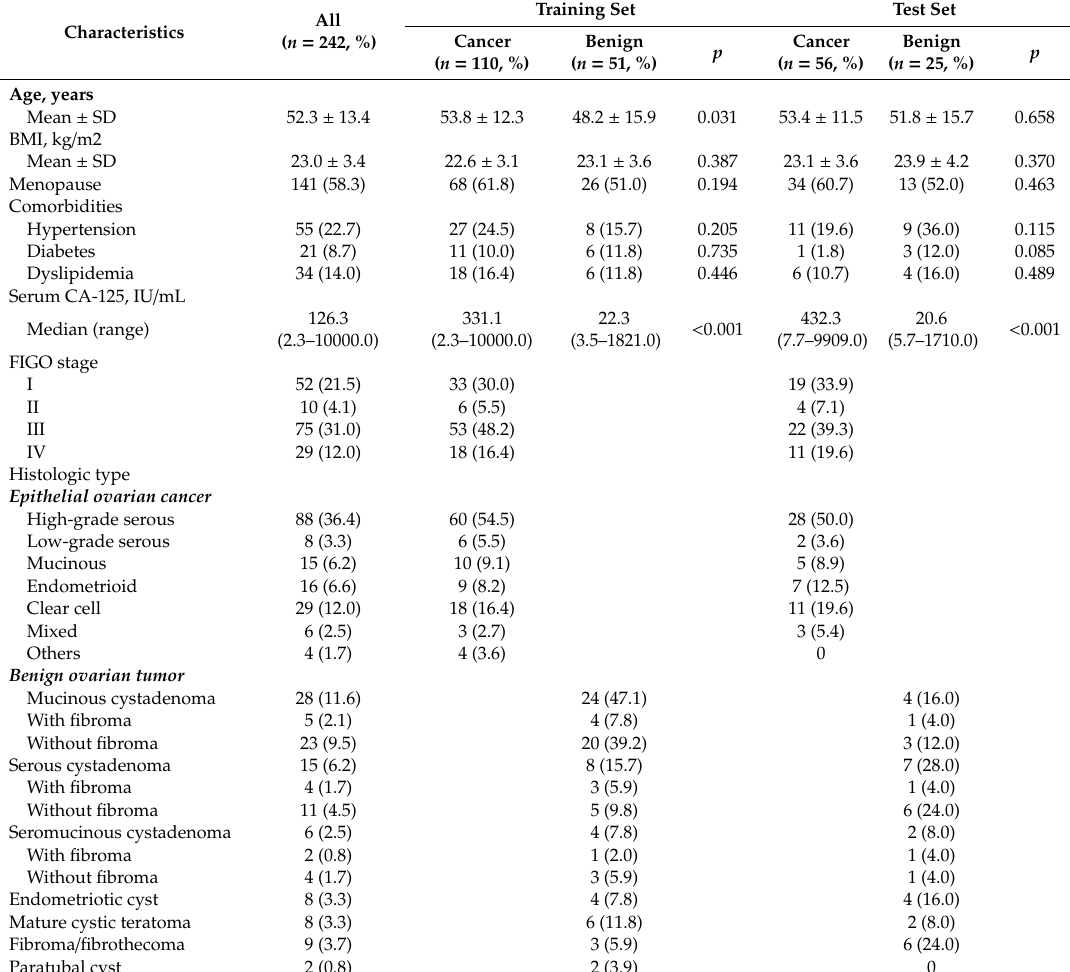
Table 1. Patients’ clinicopathologic